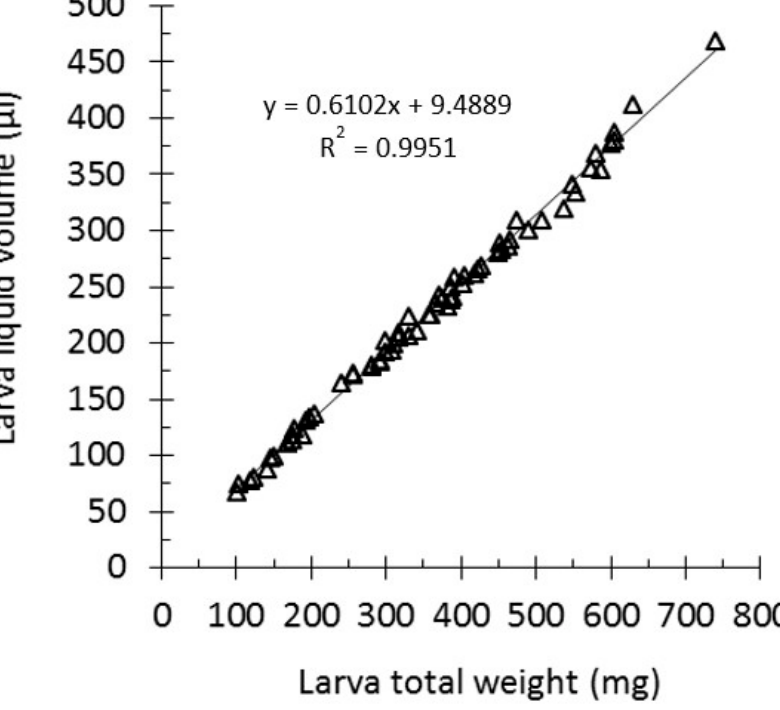
Figure 1. G. mellonella larva total weight versus the liquid volume curve. Healthy larvae of different Table 3. Effects of curtailed sleep on self-reported sleepiness, tiredness, quality of sleep and hunger. sizes ( n = 66) were weighed and freeze-dried. The wet-minus-dry weight was the larva liquid weight, which was found to be almost identical to the liquid volume. Each triangle represents data from a single larva. The regression line was drawn, and the coefficient of determination R square was calculated in